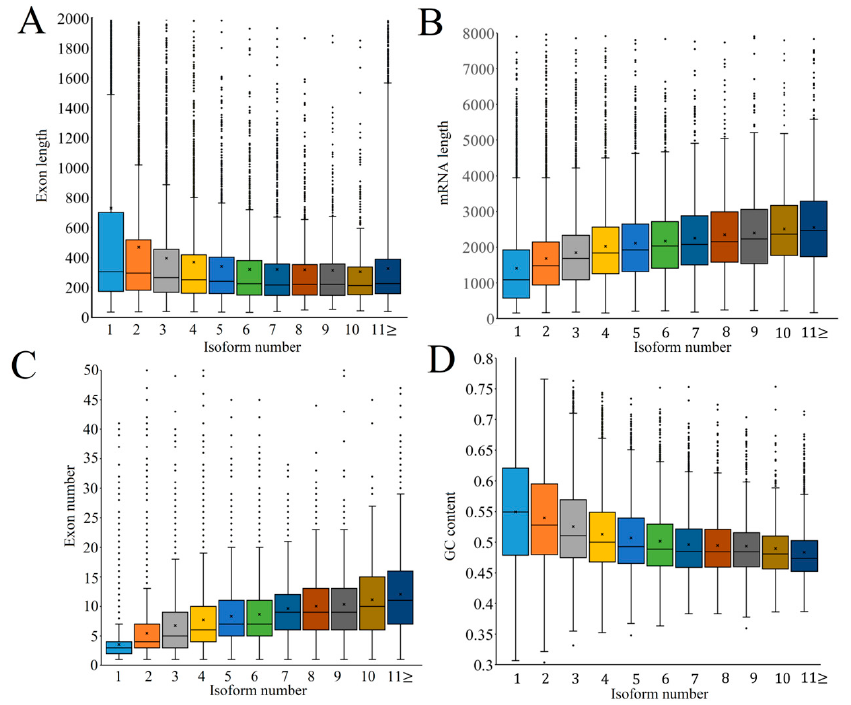
Figure 6. The relationship between gene structures and the number of isoforms per gene. ( A ) Exon length. ( B ) mRNA. ( C ) Exon number. ( D ) GC content.